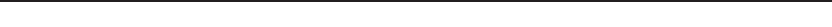
Table 1. Site Options and Service Delivery Modalities.